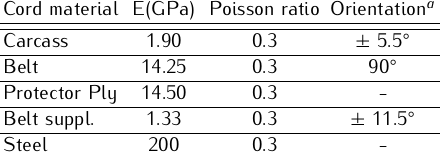
Table 2. Material parameters of cord layers